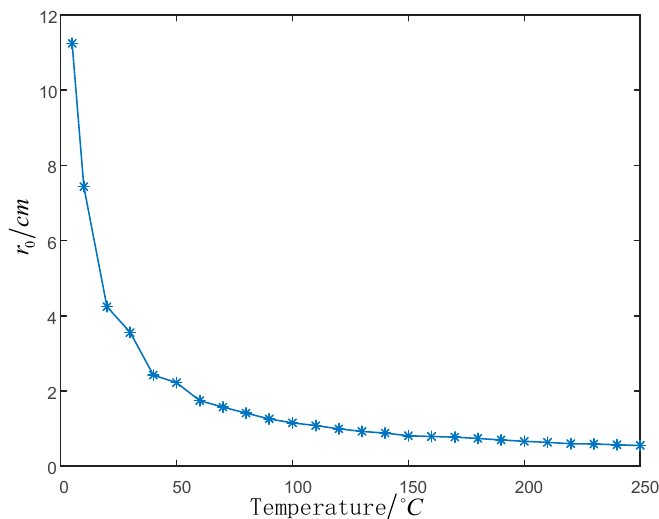
Figure 3. Variation of large gas coherence length with temperature difference.